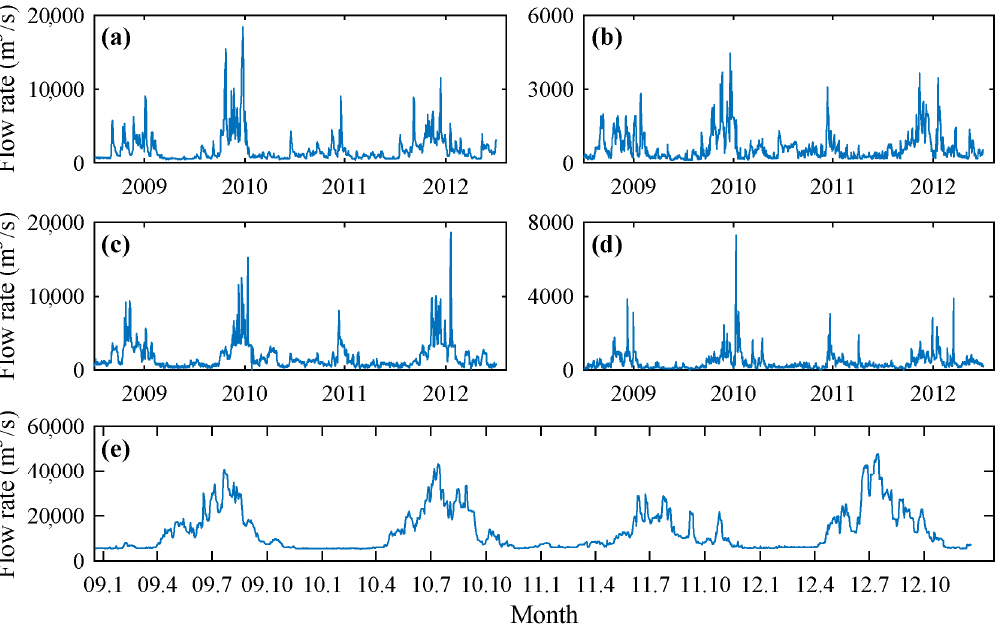
Figure 2. Time series of daily discharges of the ( a ) Xiang River, ( b ) Zi River, ( c ) Yuan River, ( d ) Li River, and ( e ) Yangtze River.